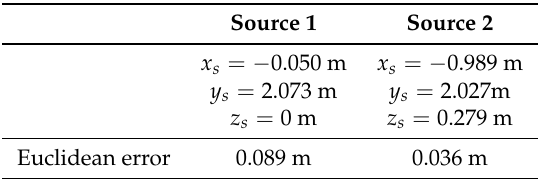
Table 1. Results of the estimation of parameters in the 3D localization. The theoretical position of